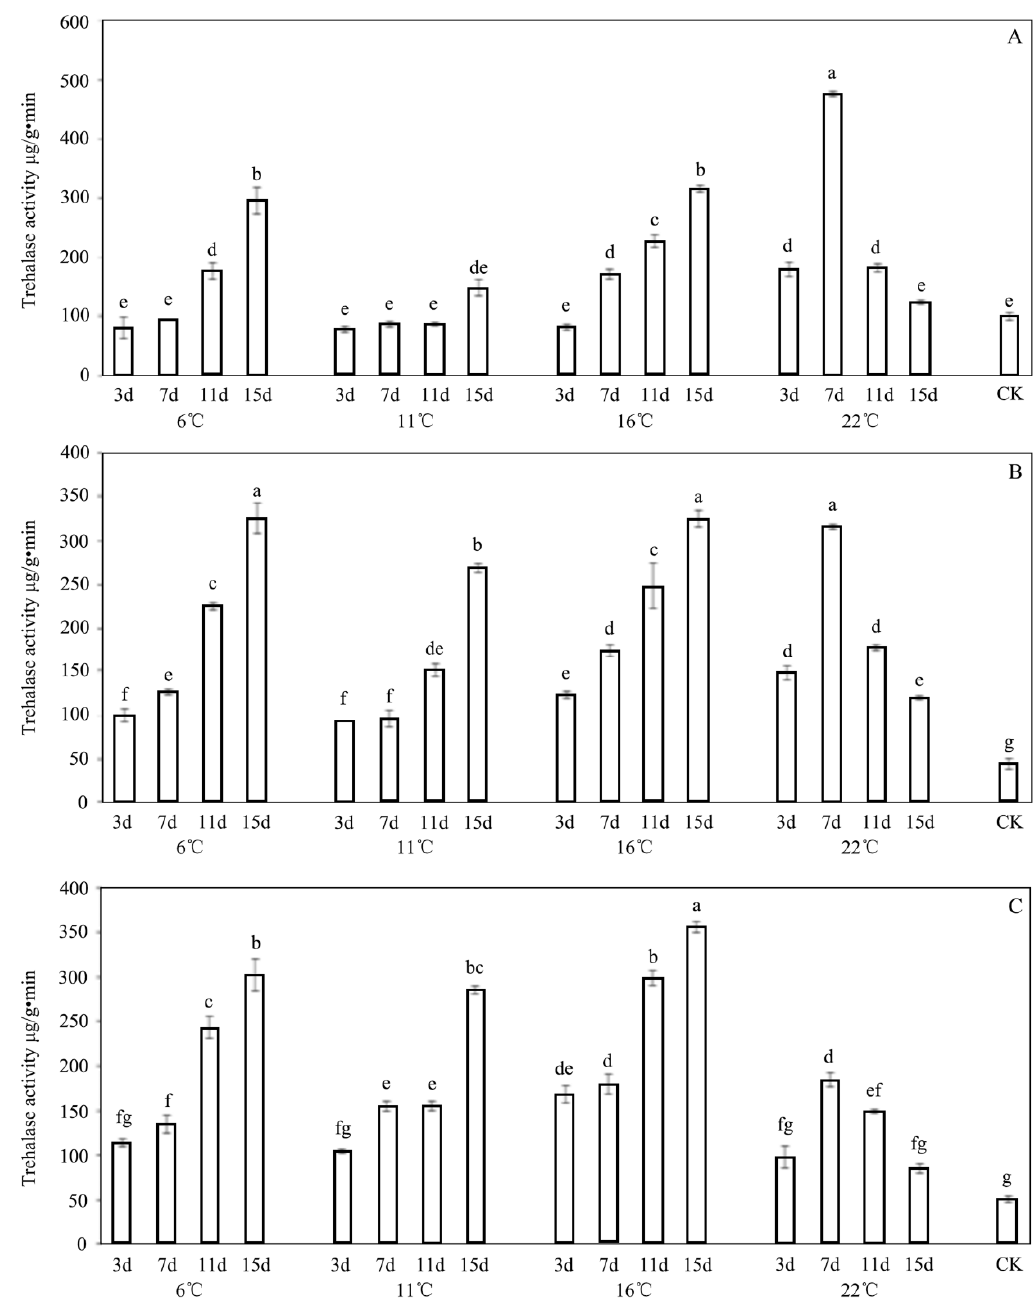
Figure 5. Effect of P. syringae 1.3200 concentration on trehalase activity of third-instar larvae of E. extimalis . ( A ) 0.1 OD; ( B ) 0.2 OD; ( C ) 0.3 OD. Results are shown as the mean ± SD. Letters on the error bars indicate significant differences analyzed by the one-way analysis of variance (ANOVA) with Tukey’s test ( p <